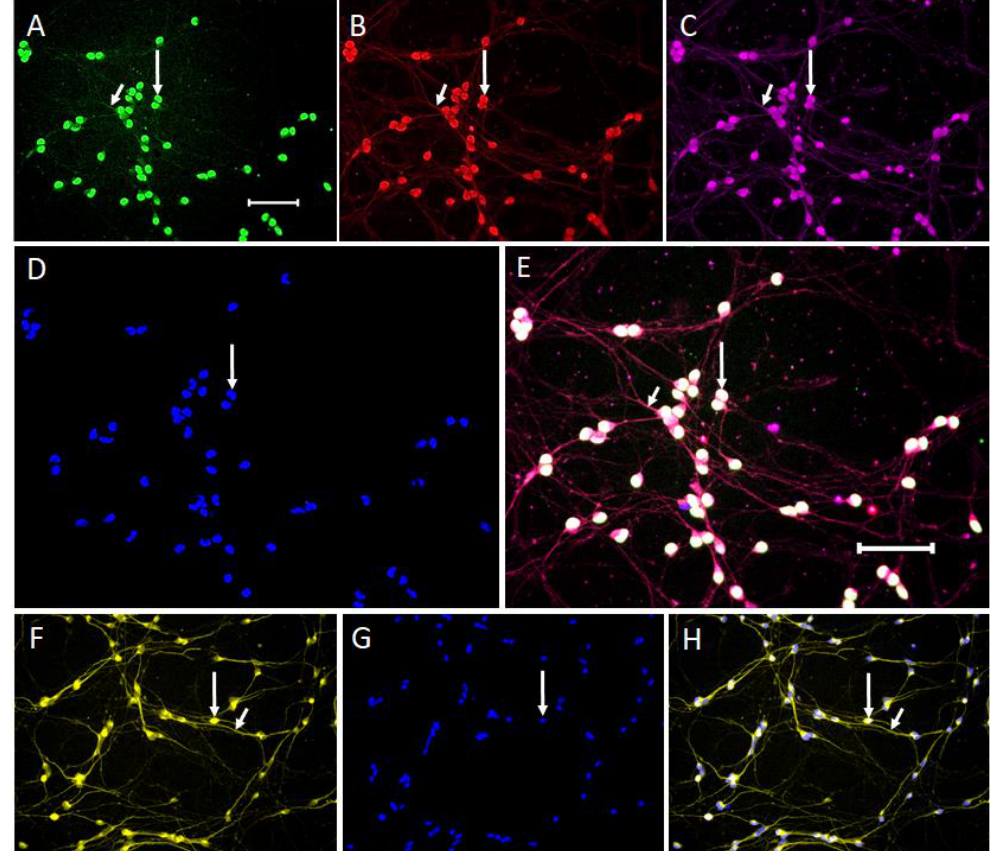
Figure 3. Triple immunolabeling of LUHMES cells for: tyrosine hydroxylase (TH) (( A ), green), aro- matic L-amino acid decarboxylase (( B ), red), and dopamine transporter (( C ), magenta), and staining of cell nuclei with 4 ′ ,6-diamidino-2-phenylindole dihydrochloride (DAPI) (( D ), blue). Colo- calization of all four markers results in white staining of cells ( E ). Monoimmunolabeling of LUHMES cells for tyrosine hydroxylase with the use of rabbit-anti-TH (( F ), yellow), staining of cell nuclei with DAPI (( G ), blue), merged result (( H ), lilac). Long arrow, cell bodies stained with all four markers; short arrow, cell processes (neurites) immunostained for three proteins of the dopaminer- gic phenotype. Bar: 100 µm.